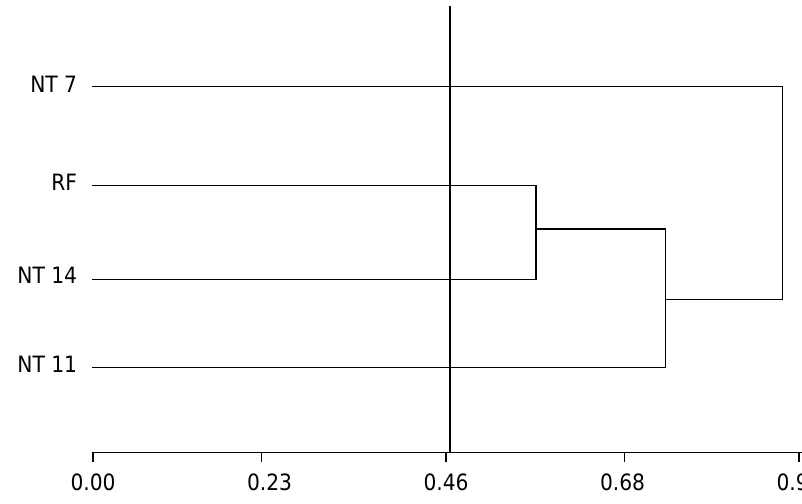
0.00 Figure 2. Clustering analysis of bacterial communities physiological profiles. Correlation = 0.87**. RF = reference area (murundus field); NT7 = area converted into no-tillage system for 7 years; NT11 = area converted into no-tillage system for 11 years; NT14 = area converted into no-tillage system for 14 years.